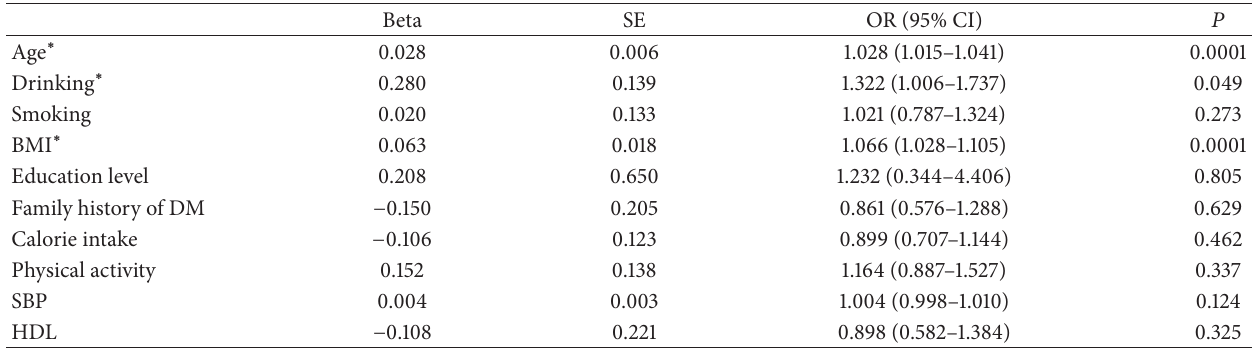
Table 3: Multivariate logistic regression analysis of prediabetes (drinking as a single